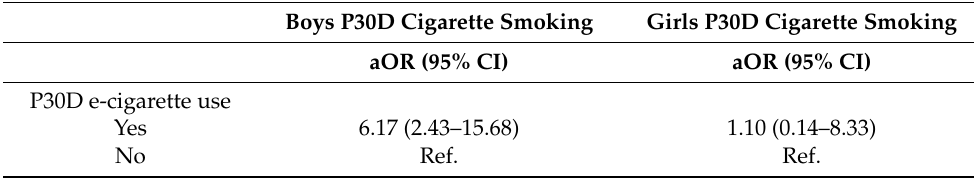
Table 4. Adjusted odds ratios (aORs) 1 from subgroup analysis for adolescent boys and